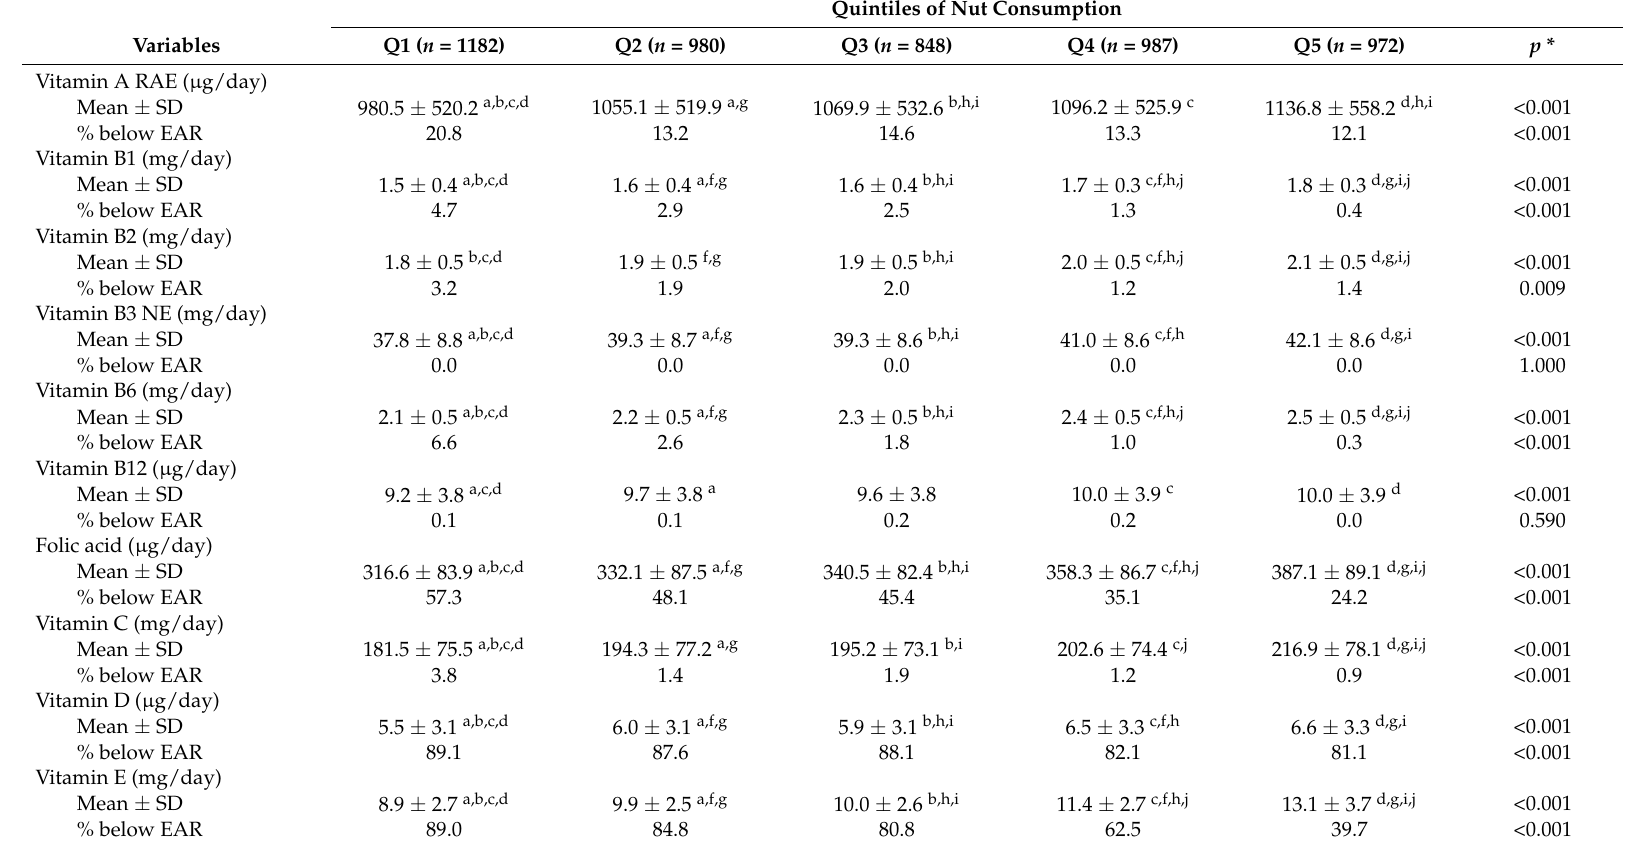
Table 3. Usual intake of vitamins and minerals of the nut consumers ( n =